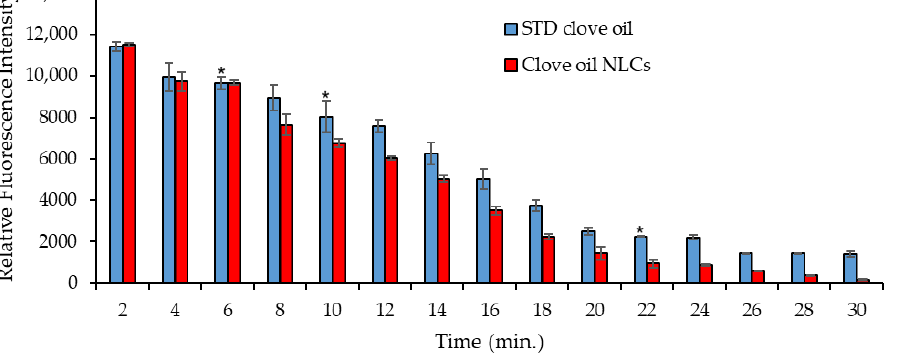
Figure 8. Quantification of CO accumulation and excretion in shrimp at different times after recovery. The comparison lines indicate a significant higher relative fluorescence intensity ( p < 0.05) gained from the STD-CO compared to the CO-NLCs. (*) indicates a significant difference ( t -test, p < 0.05) between STD-CO and CO-NLCs for the particular concentration.